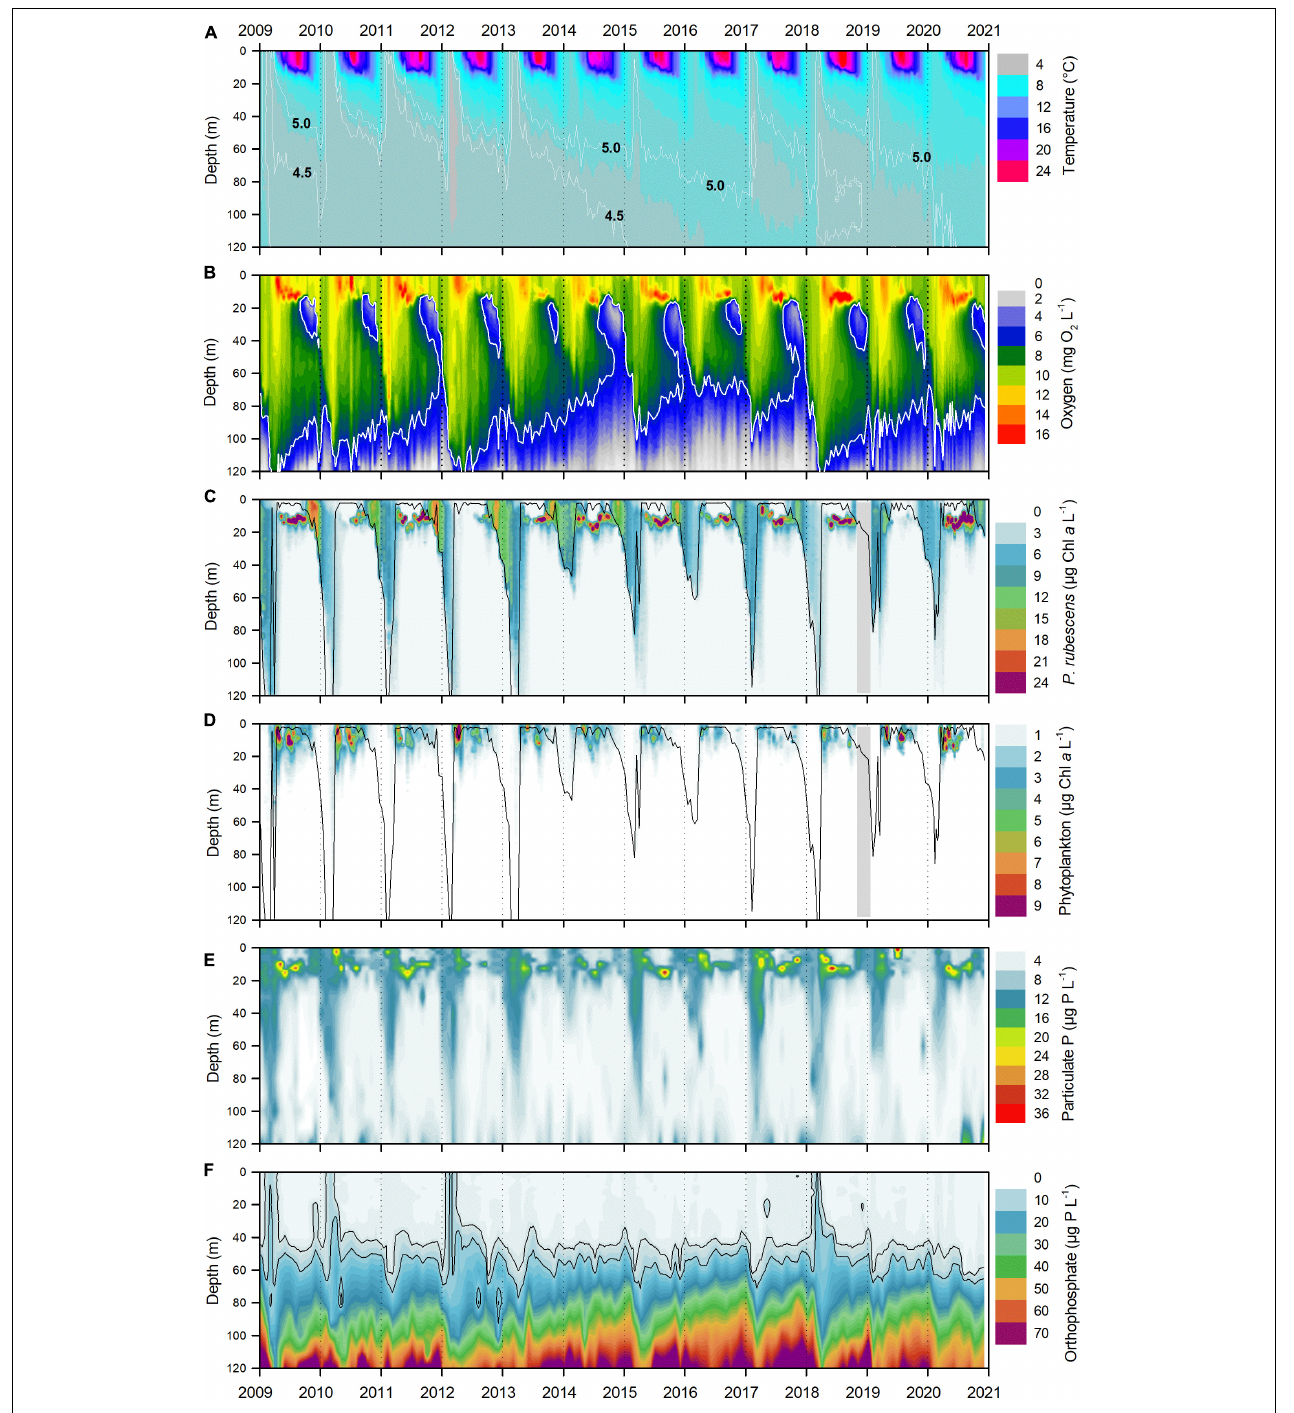
FIGURE 1 | Trends (2009–2020) in thermal stratification, oxygen concentration, phytoplankton chlorophyll values, and phosphorus concentrations in Lake Zurich (Switzerland). (A) Water temperature with two white isotherms indicating 4.5 and 5.0 ◦ C, respectively. (B) Oxygen concentration (mg O 2 L – 1 ) with white isoline indicating 6 mg O 2 L – 1 (see text for details). (C) In vivo chlorophyll a concentration ( µ g Chl a L – 1 ) of the cyanobacterium Planktothrix rubescens . Gray area: no measurements from November 2018 to January 2019. (D) In vivo chlorophyll a concentration ( µ g Chl a L – 1 ) of total eukaryotic phytoplankton. Gray area: no measurements from November 2018 to January 2019. Black lines in panels (C,D) indicate the surface mixed layer ( z mix ). (E) Concentrations of particulate phosphorus ( µ g P L – 1 ). (F) Concentrations of orthophosphate ( µ g P L – 1 ) with two black isoline indicating 5 and 10 µ g P L – 1 , respectively. Panels (A–D) are based on weekly/biweekly profiles ( n = 320) of parameters, measured with multiparameter probes and interpolated in 1 m steps between 0 and 120 m depth ( n = 38,420). Panels (E,F) are based on monthly analyses ( n = 144) of 15 sampling depths between 0 and 120 m ( n = 2,160).